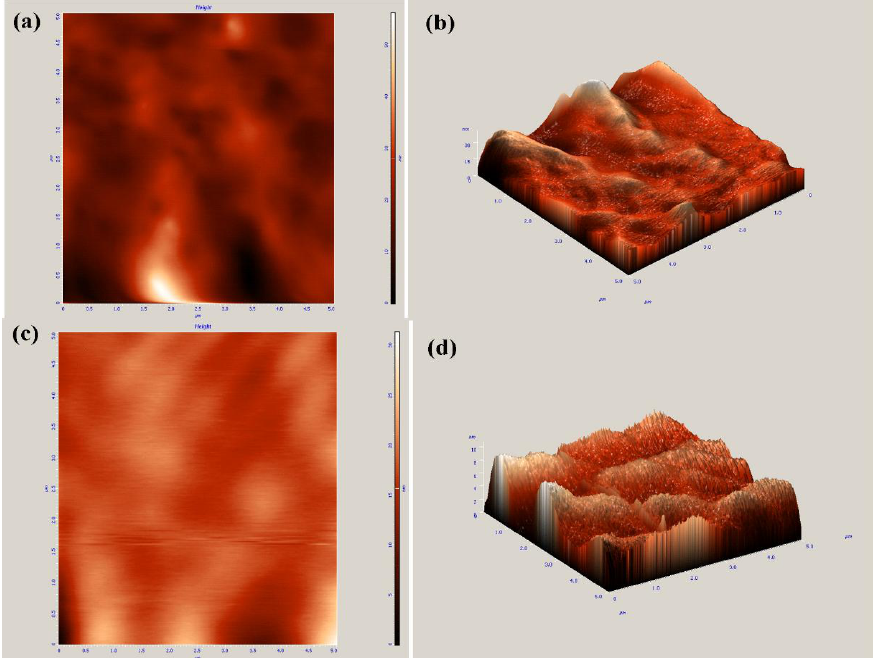
Fig. 4. AFM images of: (a,b) A7 and (c,d) A8 samples.